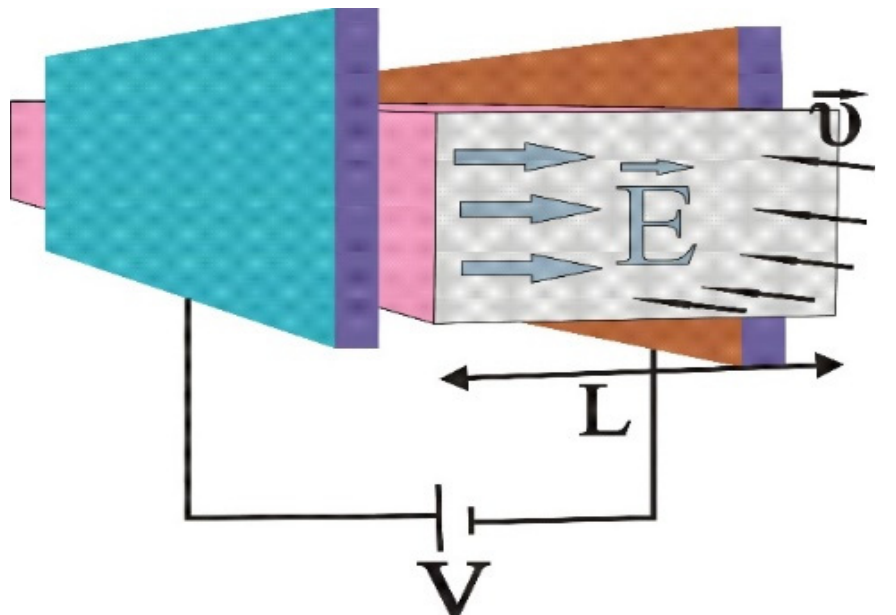
Figure 1. Configuration of the toxin drift model (V: voltage of the electrodes, L: width of the duct, → υ : velocity of contaminated water). The electrodes of the capacitor that E: electric field intensity, create the electric field between them are represented as well as the duct with the contaminated water flowing inside it perpendicular to the electric field intensity.